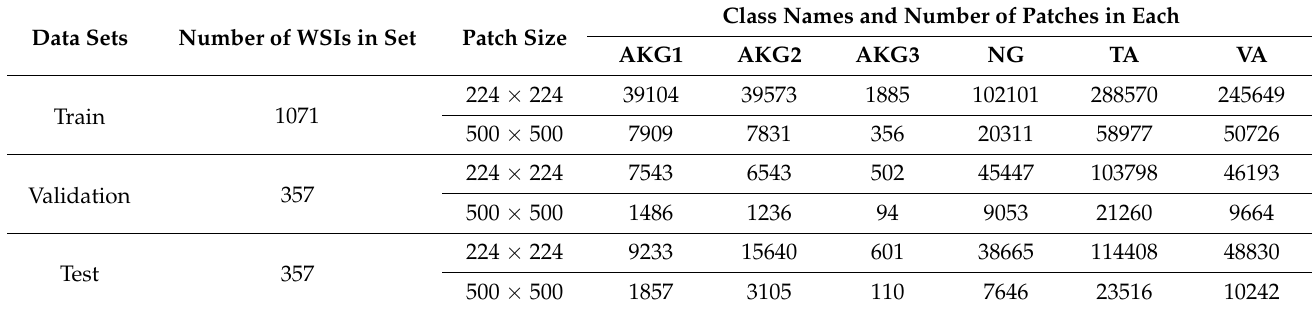
Table 3. Results of the splitting of the whole dataset on train, validation, and test sets.